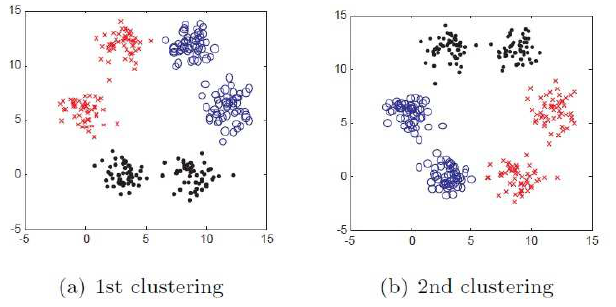
Figure 4. Two alternative clusterings of the same dataset, each with 3 clusters. Point shapes show cluster membership, adapted